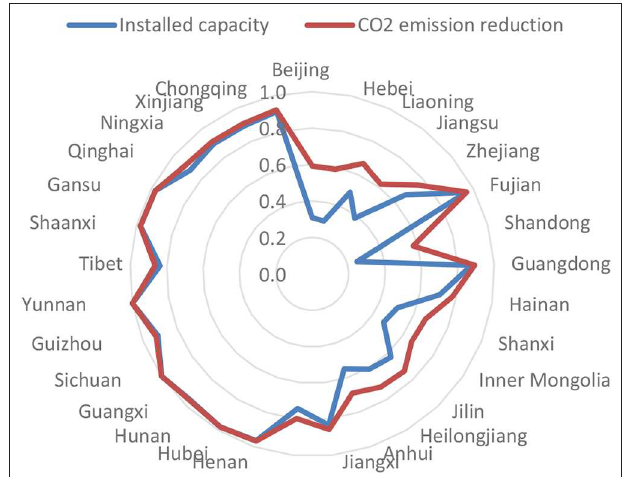
FIGURE 5 | Radar contrast chart of installed capacity and CO 2 emission